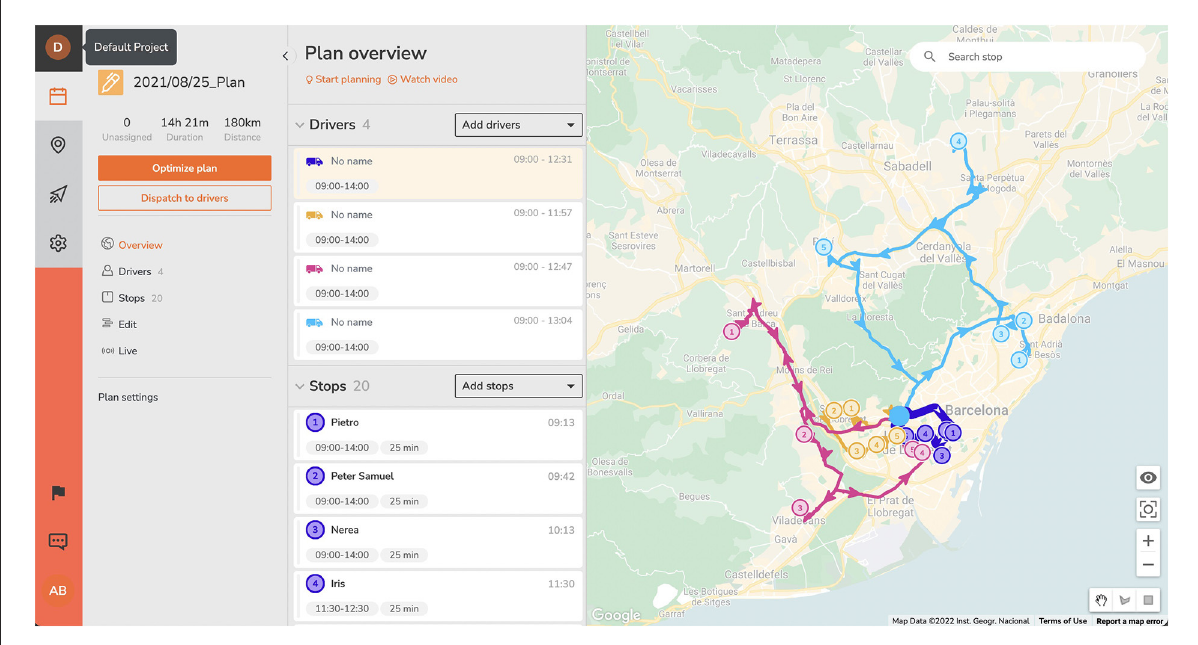
FIGURE1 Optimized plan with